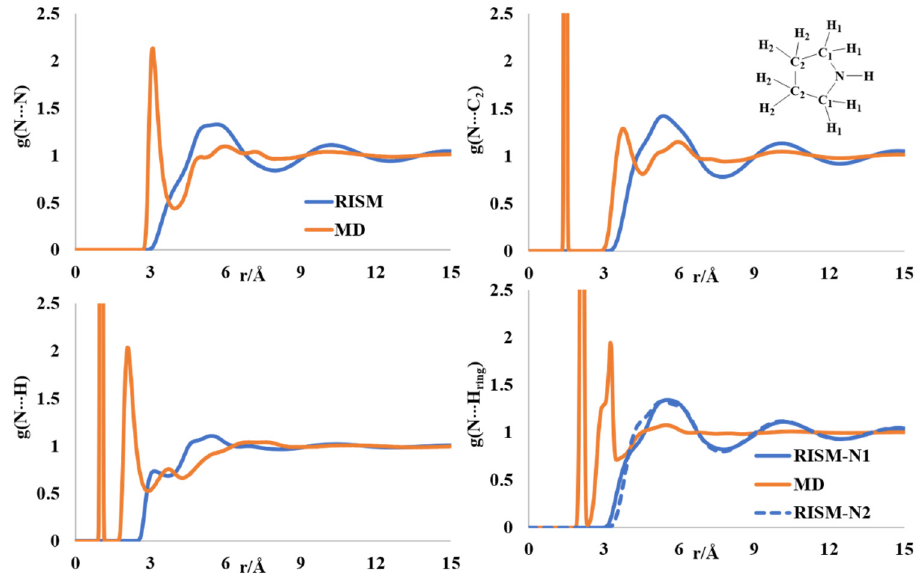
Figure 5. RISM- and MD-computed distribution functions for liquid